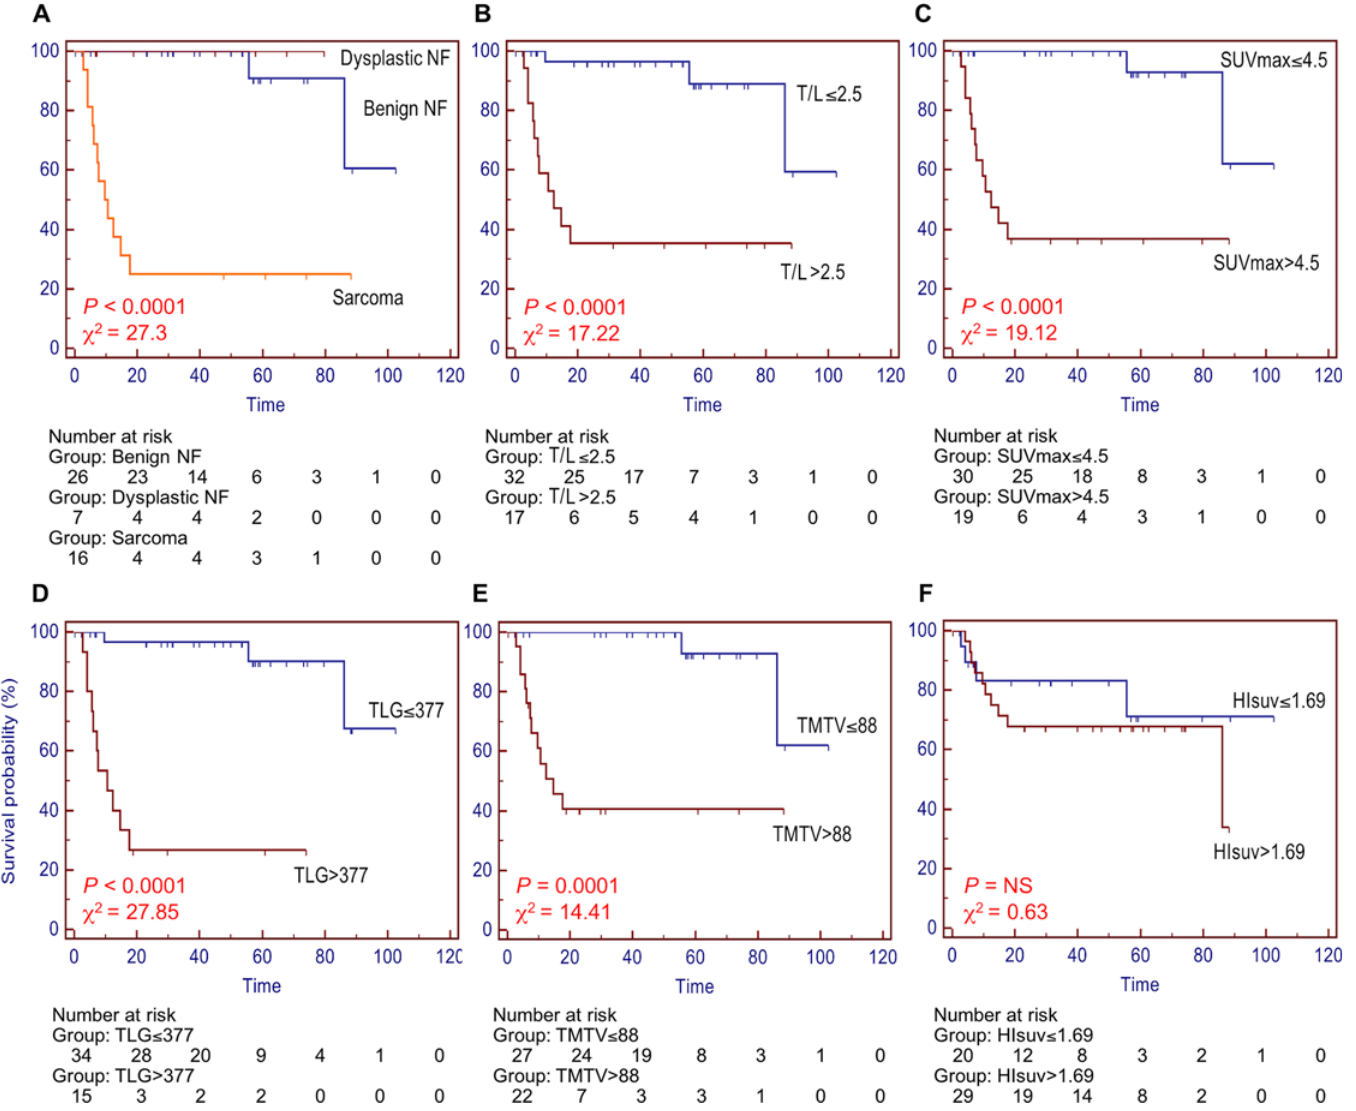
Fig 3. Kaplan-Meier estimates of overall survival with number of patients at risk at different time points depending on histopathology (A) and metabolic measures: T/L ratio (B), SUV max (C), TLG (D), TMTV (E), HI suv (F) calculated in the whole population (n = 49, median follow-up 50 mo).